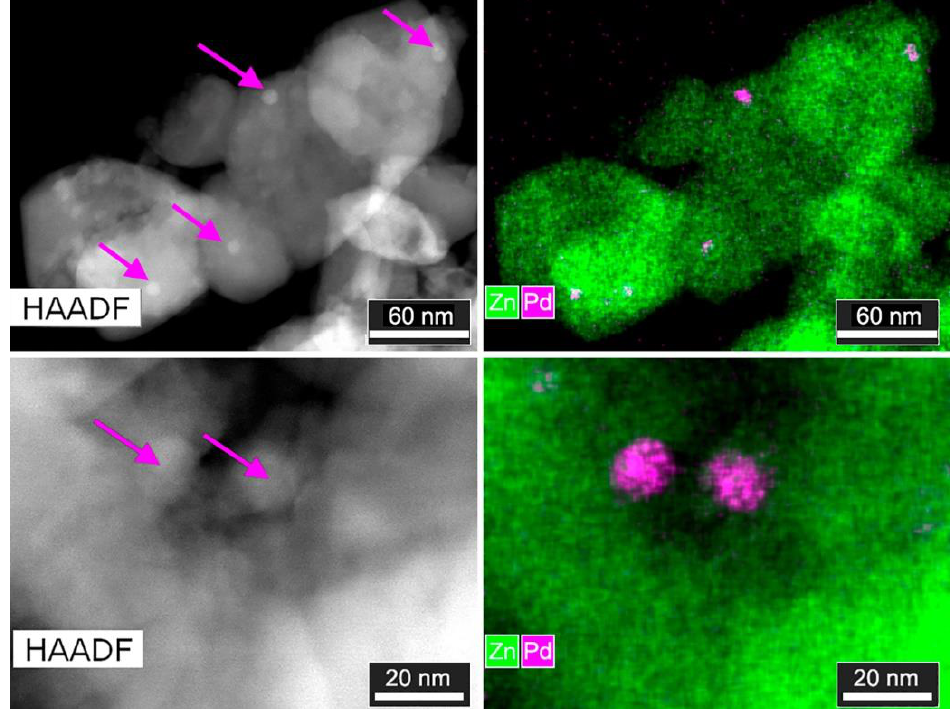
Figure 3. High angle annular dark field scanning transmission electron microscopy (HAADF-STEM) images and STEM-energy-dispersive X-ray (EDX) maps of ZnO/Pd sample at different magnifications. At HAADF-STEM image Pd nanoparticles are indicated with arrows.